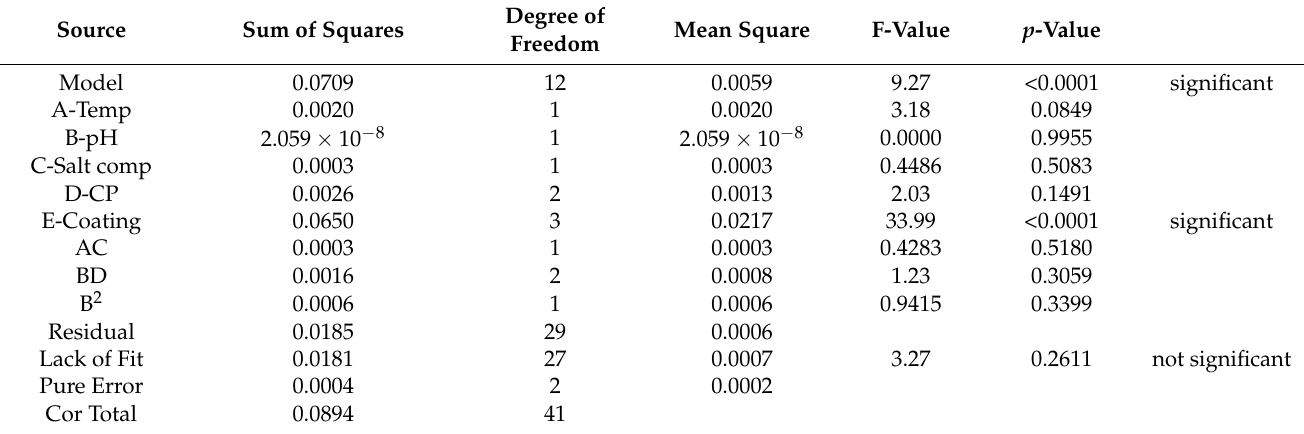
Table 5. ANOVA test for modified quadratic